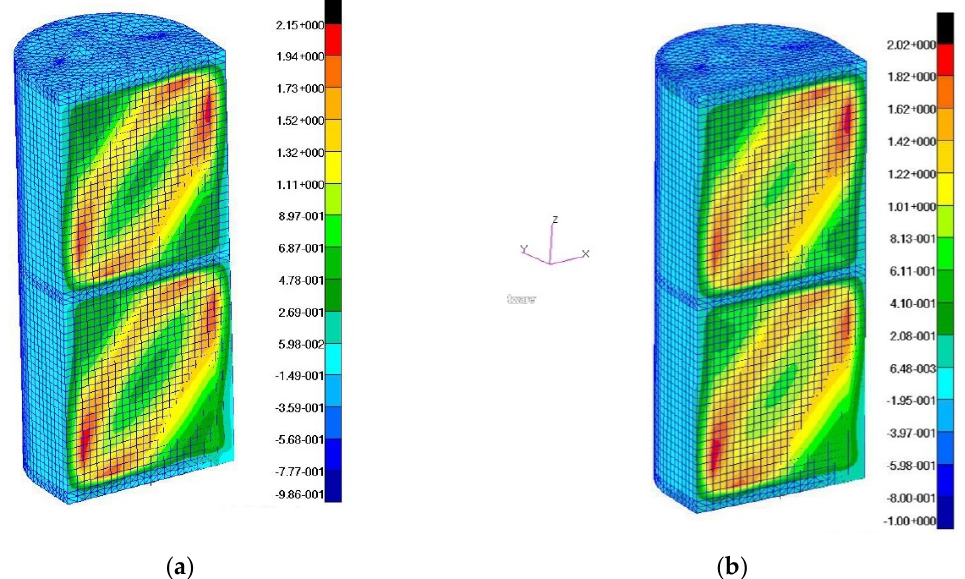
Figure 20. Distributions of tangential stresses: ( a ) a wall with fiber orientation corresponding to the X, Z directions; ( b ) a wall with fiber orientation at an angle of 45 degrees to the X, Z directions.